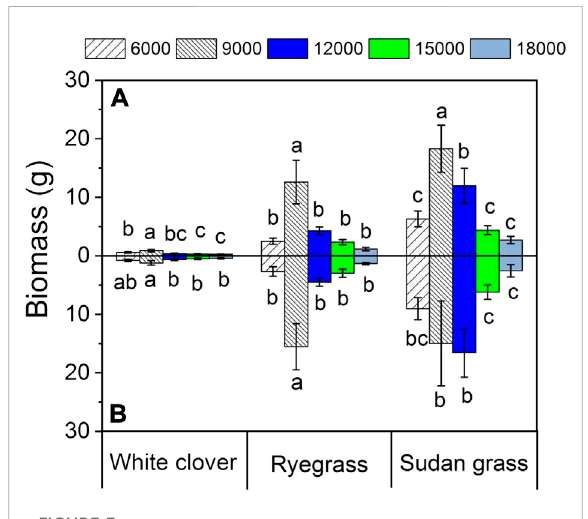
FIGURE 2 Plant height under different petroleum hydrocarbons concentrations. The values shown are the mean ± SE ( n = 3). The same letters among speci fi c treatments are not signi fi cantly different according to Duncan ’ s (0.05). Thus, (A) : treatments without glycine; (B) : treatments with glycine. 6000, 6000 mg kg − 1 petroleum hydrocarbons contaminated soil; 9000, 9000 mg kg − 1 petroleum hydrocarbons contaminated soil; 12,000, 12,000 mg kg − 1 petroleum hydrocarbons contaminated soil; 15,000, 15,000 mg kg − 1 petroleum hydrocarbons contaminated soil; 18,000, 18,000 mg kg − 1 petroleum hydrocarbons contaminated soil.